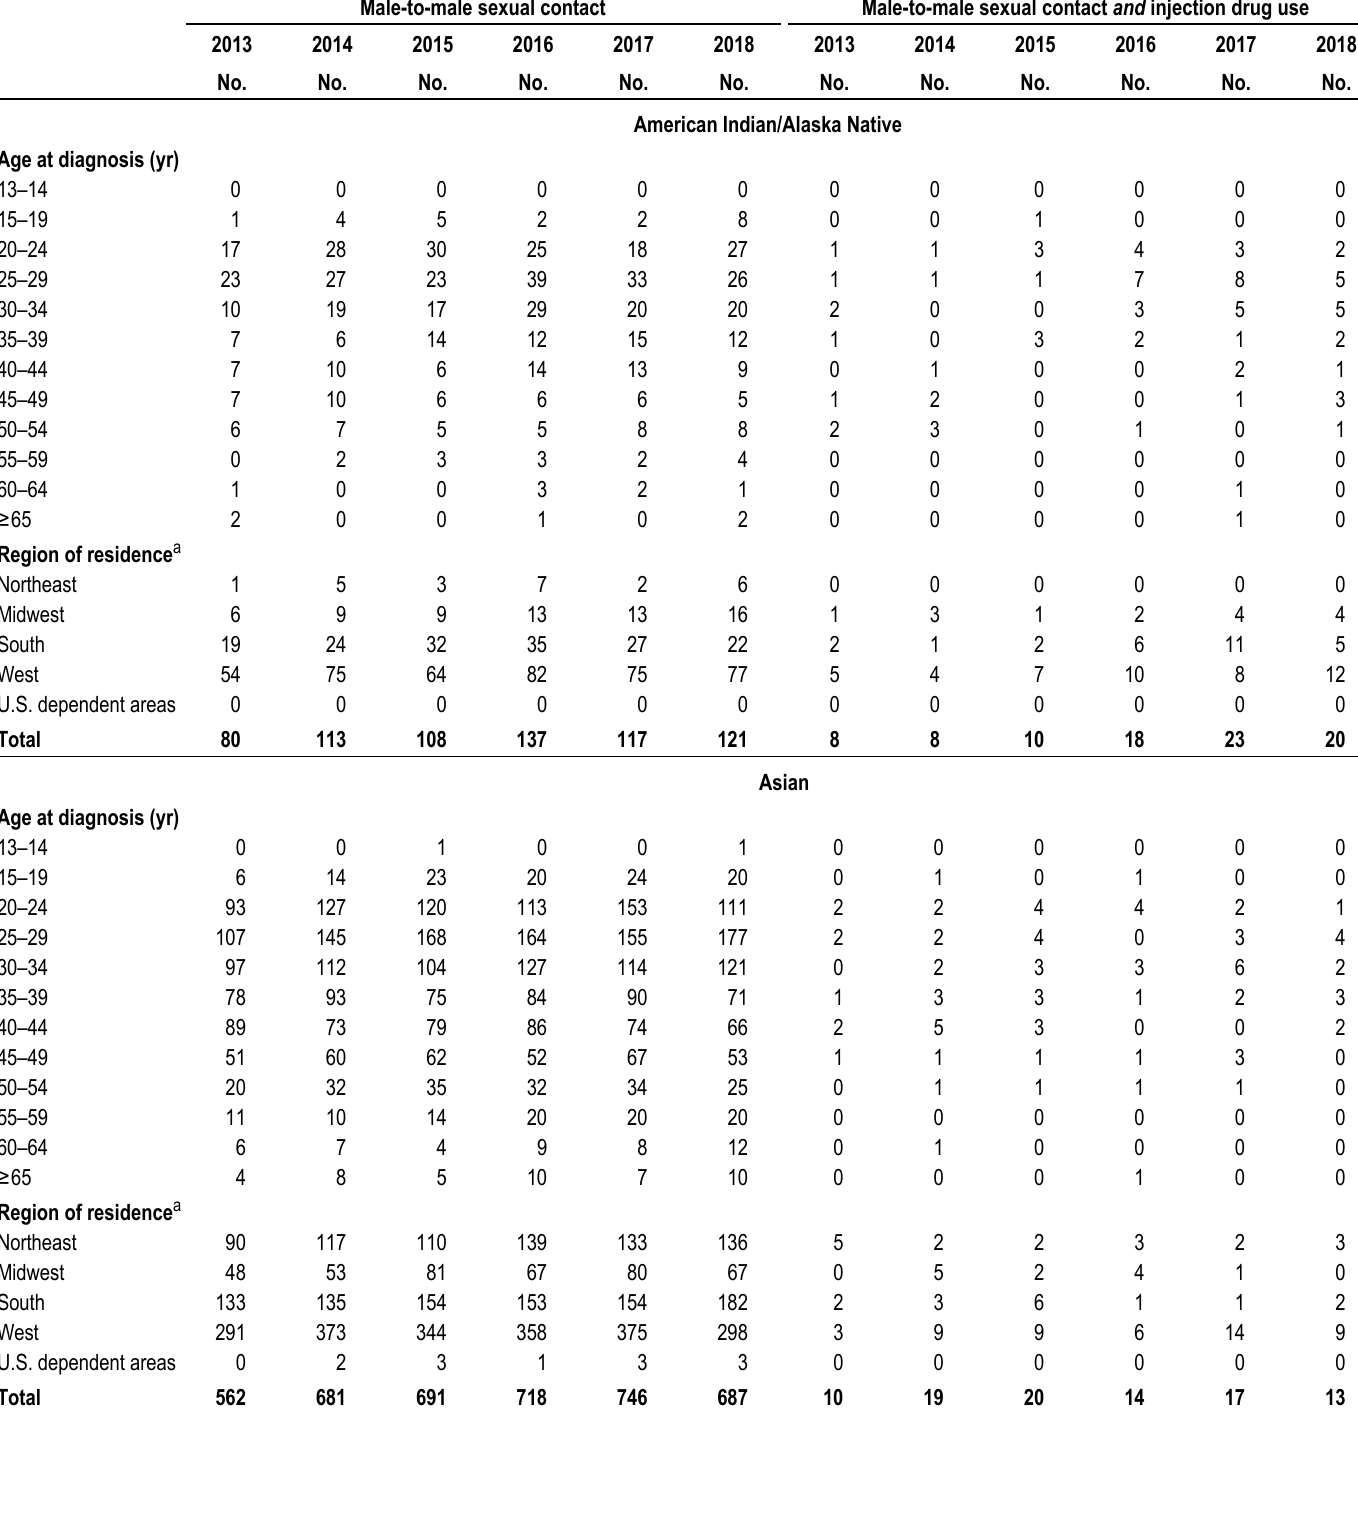
Table 7b. Diagnoses of HIV infection attributed to male-to-male sexual contact and male-to-male sexual contact and injection drug use, by selected characteristics, 2013–2018—United States and 6 dependent areas Male-to-male sexual